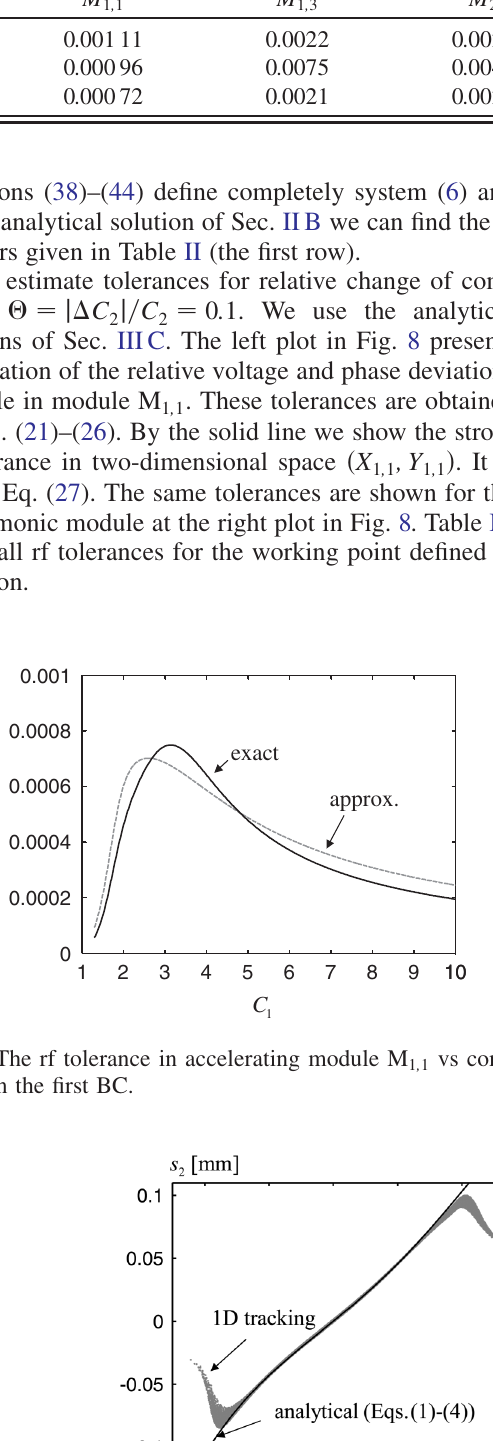
FIG. 10. The relative positions of the particles in the bunch after BC vs the initial positions after the gun. The left plot compares the 2 analytical curve [Eqs. (1)–(4)] with the particle distribution from a simple one-dimensional tracking without collective effects. The right plot compares the analytical curve with the particle distribution from 3D self-consistent